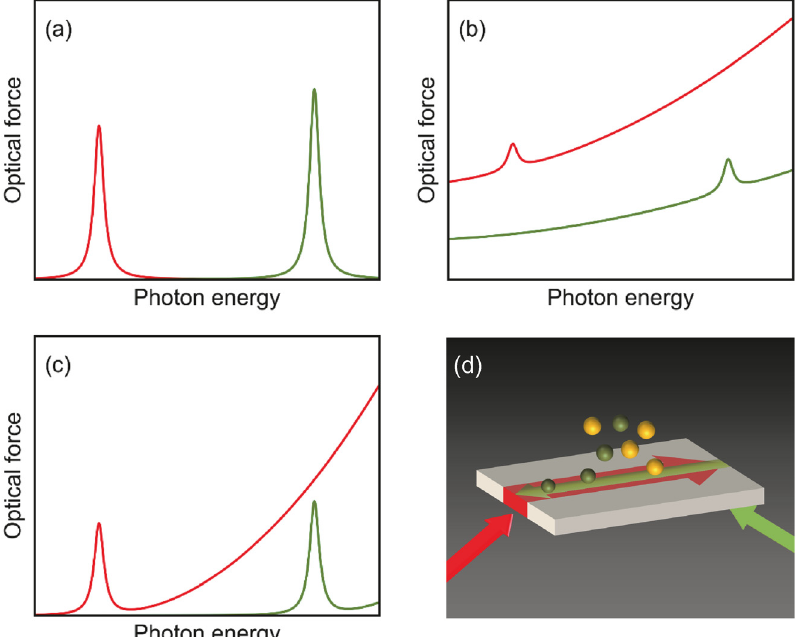
Figure1: (a)Schematicof theforcespectraof NPs with size-dependent resonance